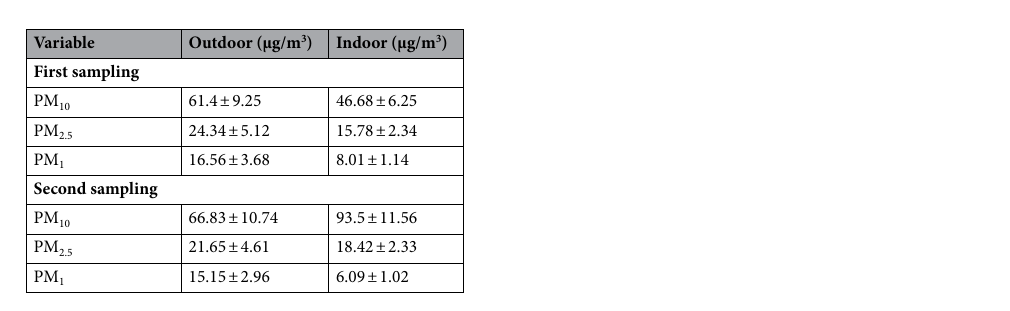
Table 2. The average concentration of indoor and outdoor particulate matter during the sampling